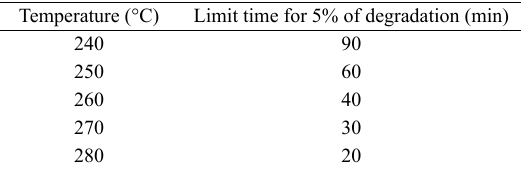
Table 3. Time limit for 5% of PA matrix degradation in different isothermal temperatures. Temperature (°C)